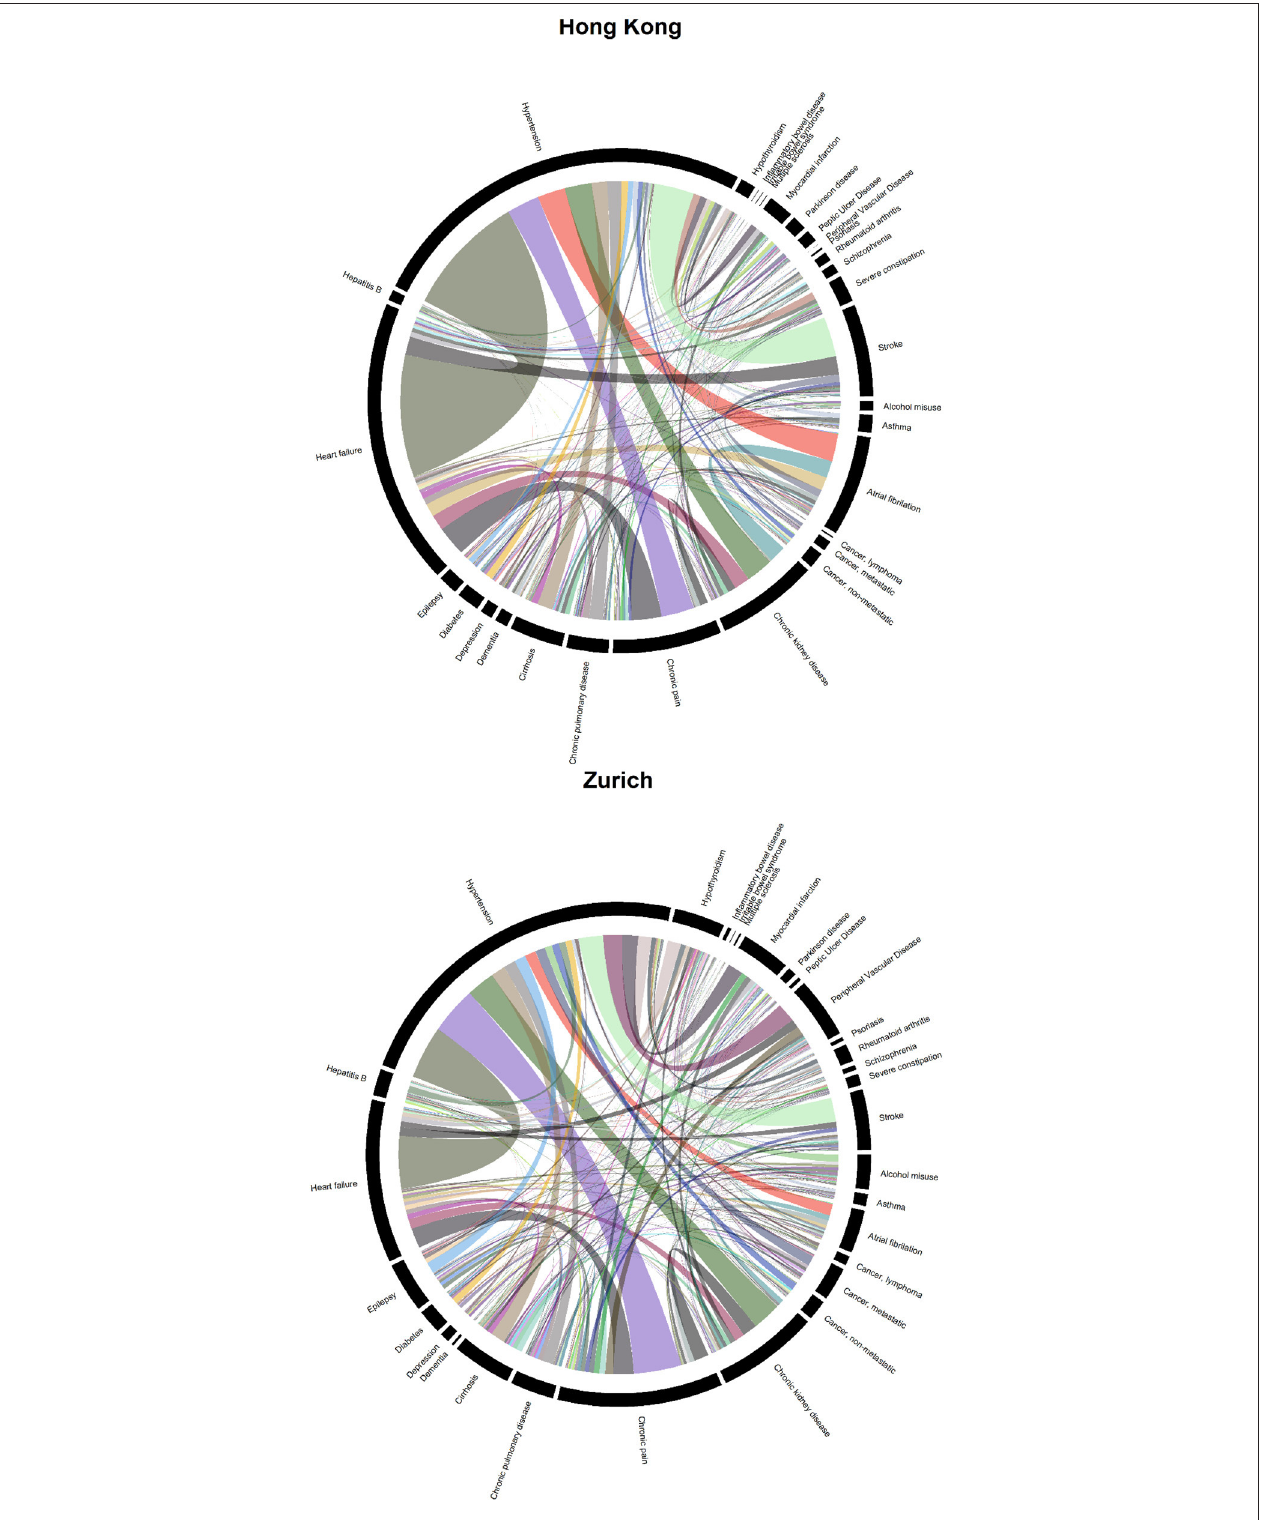
FIGURE 2 | Chord diagrams showing the frequencies of disease dyads among inpatients from Hong Kong (38,964 disease dyads) and Zurich (54,052 disease dyads).